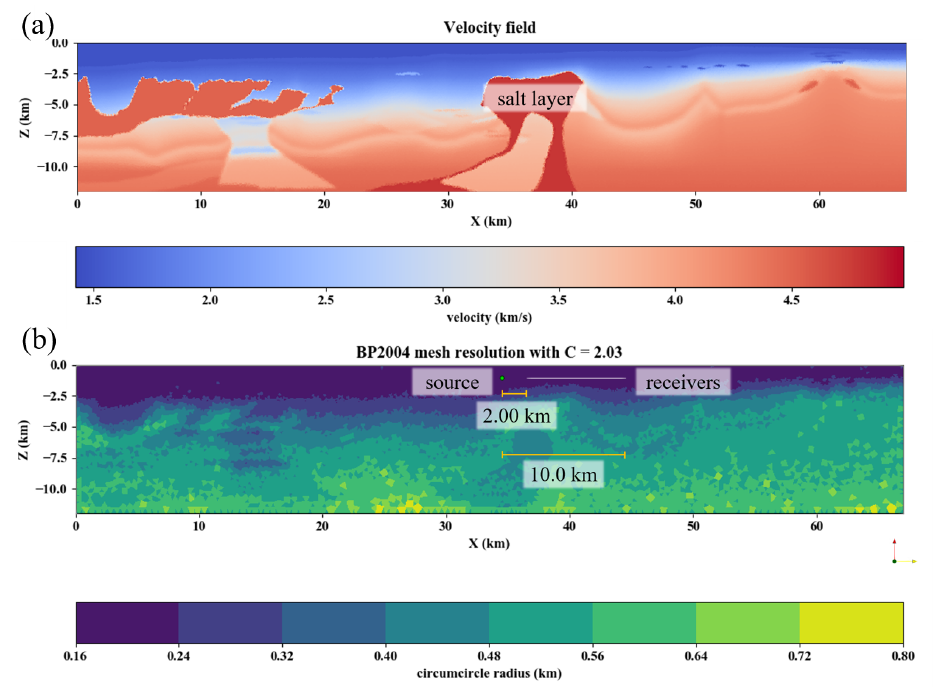
Figure 9. The reference problem configuration for the BP2004 seismic velocity model. Panel (a) shows the P -wave speed data. Panel (b) shows the mesh resolution (circumcircle diameter) based on local adaptation of the mesh resolution to the P -wave data from the BP2004 velocity model shown in panel (a) . The parameters used for mesh generation were C = 2 . 03, ML5tri, a velocity gradation rate of 15 . 0%, and an anticipated time step of (cid:49)t = 0 . 001ms.